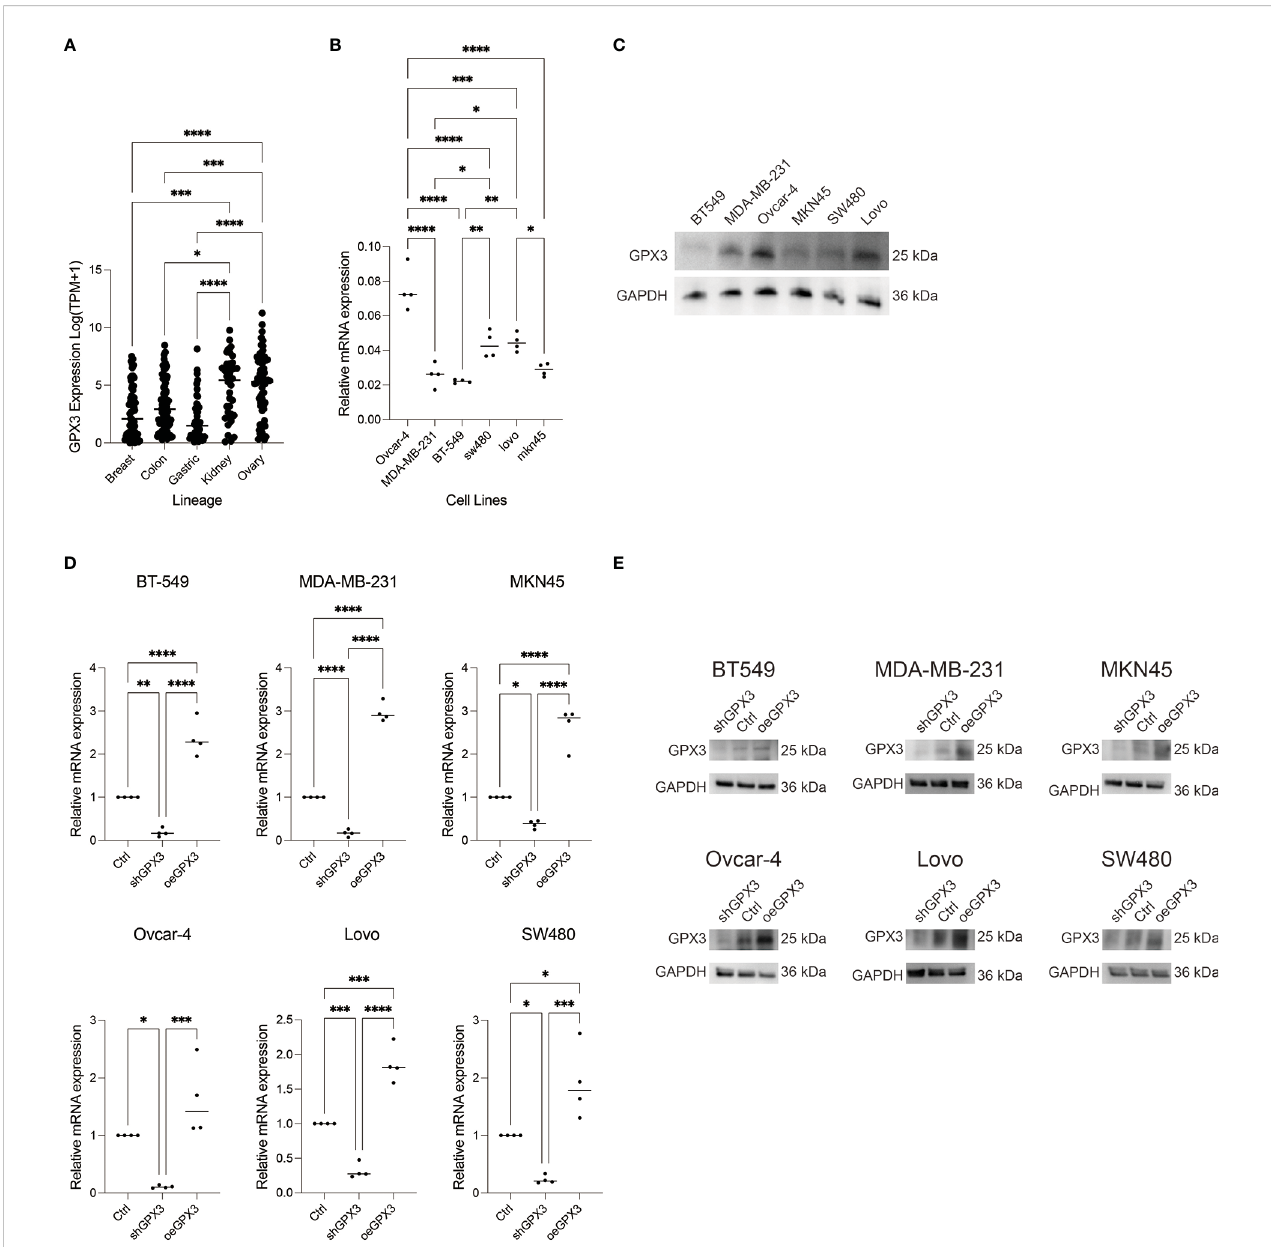
FIGURE 6 GPX3 expression in ovarian cancer (Ovcar-4), breast cancer (MDA-MB-231, BT-549), colorectal cancer (Lovo, SW480) and gastric cancer (MKN45) cell lines. (A) GPX3 expression levels in cancer cells analysed from CCLE database. (B) GPX3 expression in cancer cell lines examined by RT-PCR. (C) GPX3 expression in cancer cell lines examined by WB. (D) GPX3 expression regulation ef fi ciency in cancer cells examined by RT-PCR. (E) GPX3 expression regulation ef fi ciency in cancer cells examined by WB. *(p<0.05), **(p<0.01), ***(p<0.001),